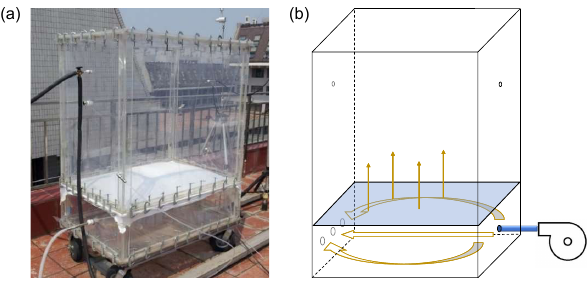
Figure 1. Photo (a) and schematic (b) of the quasi-atmospheric aerosol evolution study (QUALITY)